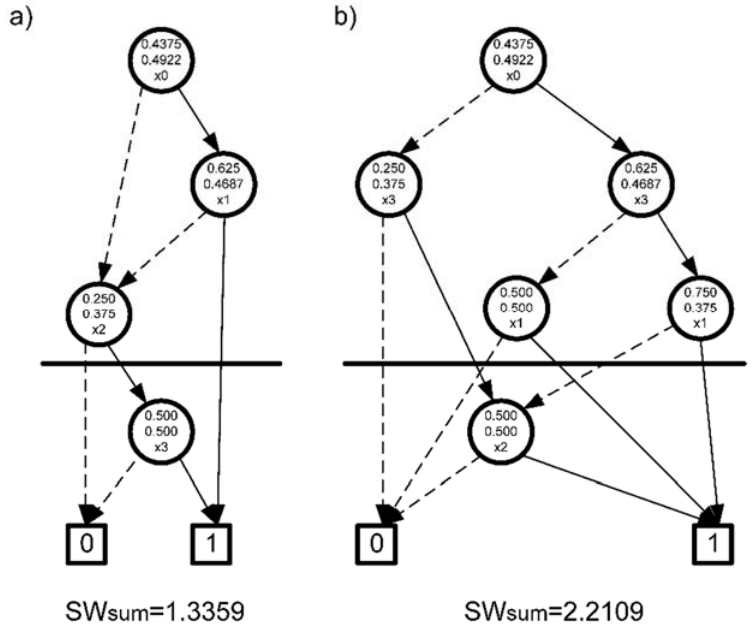
Figure 5. SWBDD for different variable orderings.